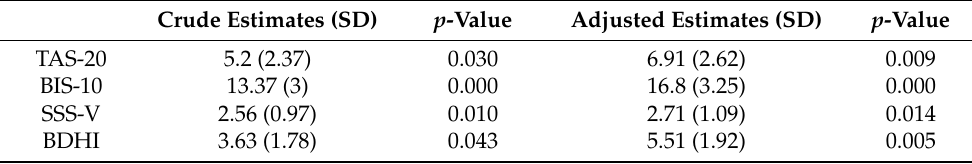
Table 5. Adjusted R-squared values for multiple linear regression.